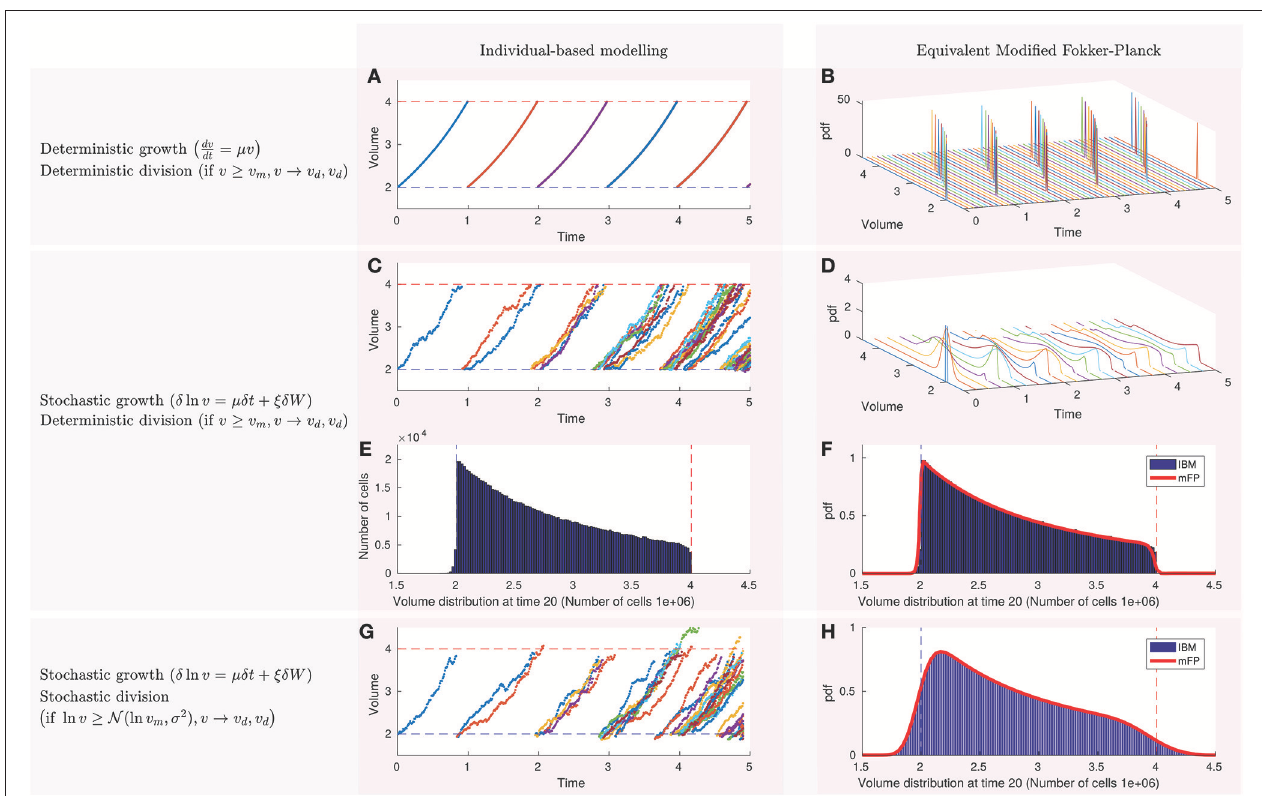
FIGURE 1 | Population statistics of bacterial growth obey a modified Fokker-Planck equation from which we can extract information about single-cell behavior. (A) Simulation of the deterministic individual-based modeling approach shows that cells grow exponentially at the same rate and divide at the same time into two cells with equal volume when reaching a critical size (the mother volume). (B) The statistics of the population volume obey a modified Fokker-Planck equation that oscillates between mother and daughter volumes without reaching a stationary distribution. (C) Individual-based modeling with stochastic growth assumes that the logarithm of the volume is subject to a stochastic fluctuation δ W characterized by a Wiener process. (D) Simulation of the equivalent modified Fokker-Plank now shows that the population volumes evolve to a stationary distribution. (E) Individual-based modeling can be used to estimate the histogram of the stationary distribution, but at the expenses of expensive computations that scale exponentially with time and linearly with the number of cells in the population. The distribution is sharp and skewed to the right and encodes single-cell features such as the mother and daughter volumes, fluctuation, and growth ratios. (F) The modified Fokker-Planck simulates the continuous shape of the stationary distribution (red line) in a efficient way that is independent on the number of cells within the population. (G) The individual-based modeling simulates stochastic growth and division. (H) The resulting stationary distribution of the population volumes is smooth and equivalent when calculated using the individual-based modeling and the modified Fokker-Planck